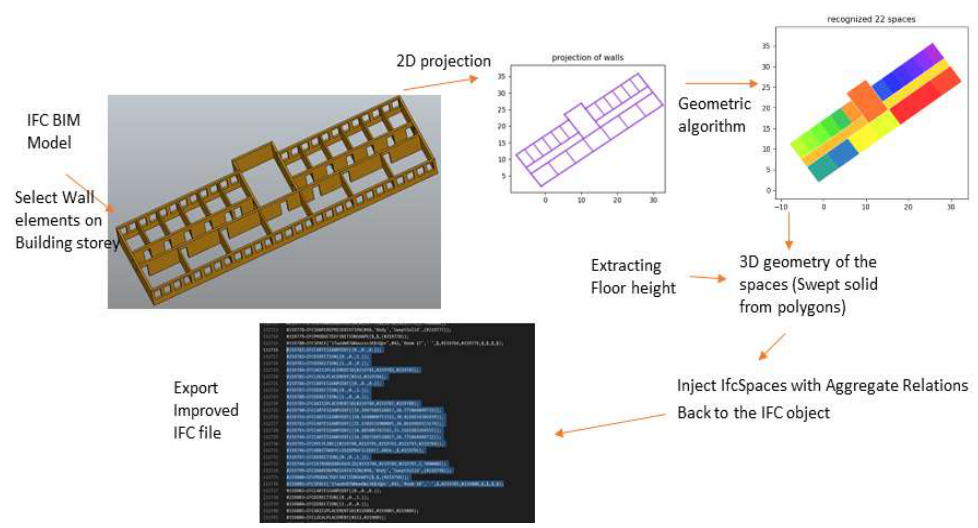
Figure 1. The visualization of the IfcSpace detection workflow.